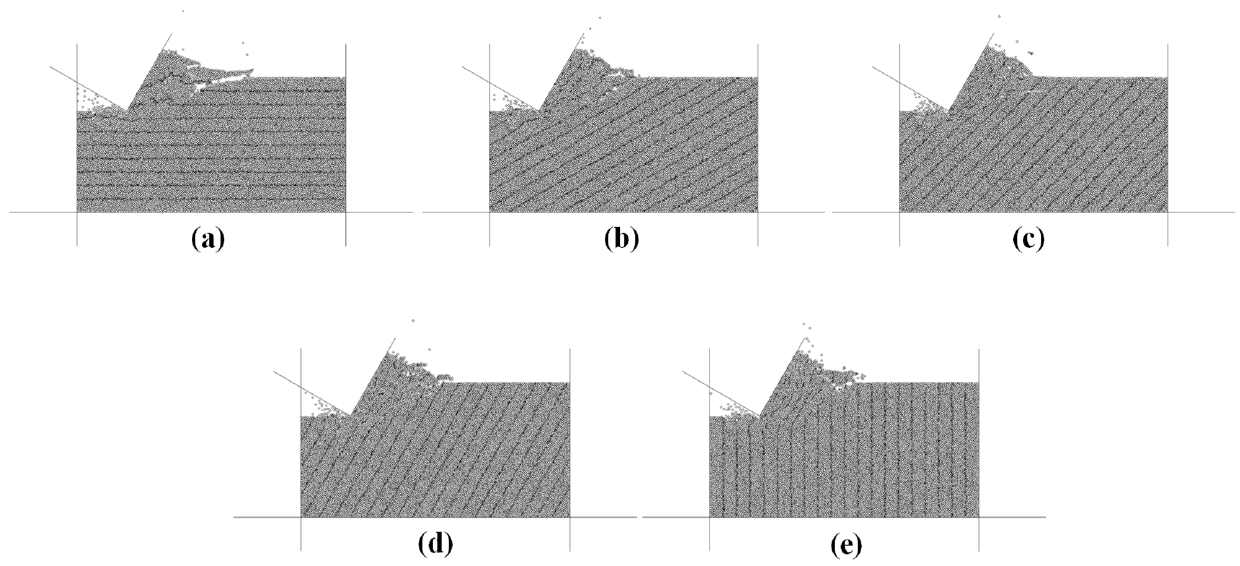
Figure 6. Cutting failure of specimens with different bedding dips: ( a ) 0°; ( b ) 30°; ( c ) 45°; ( d ) 60°; ( e ) 90°.